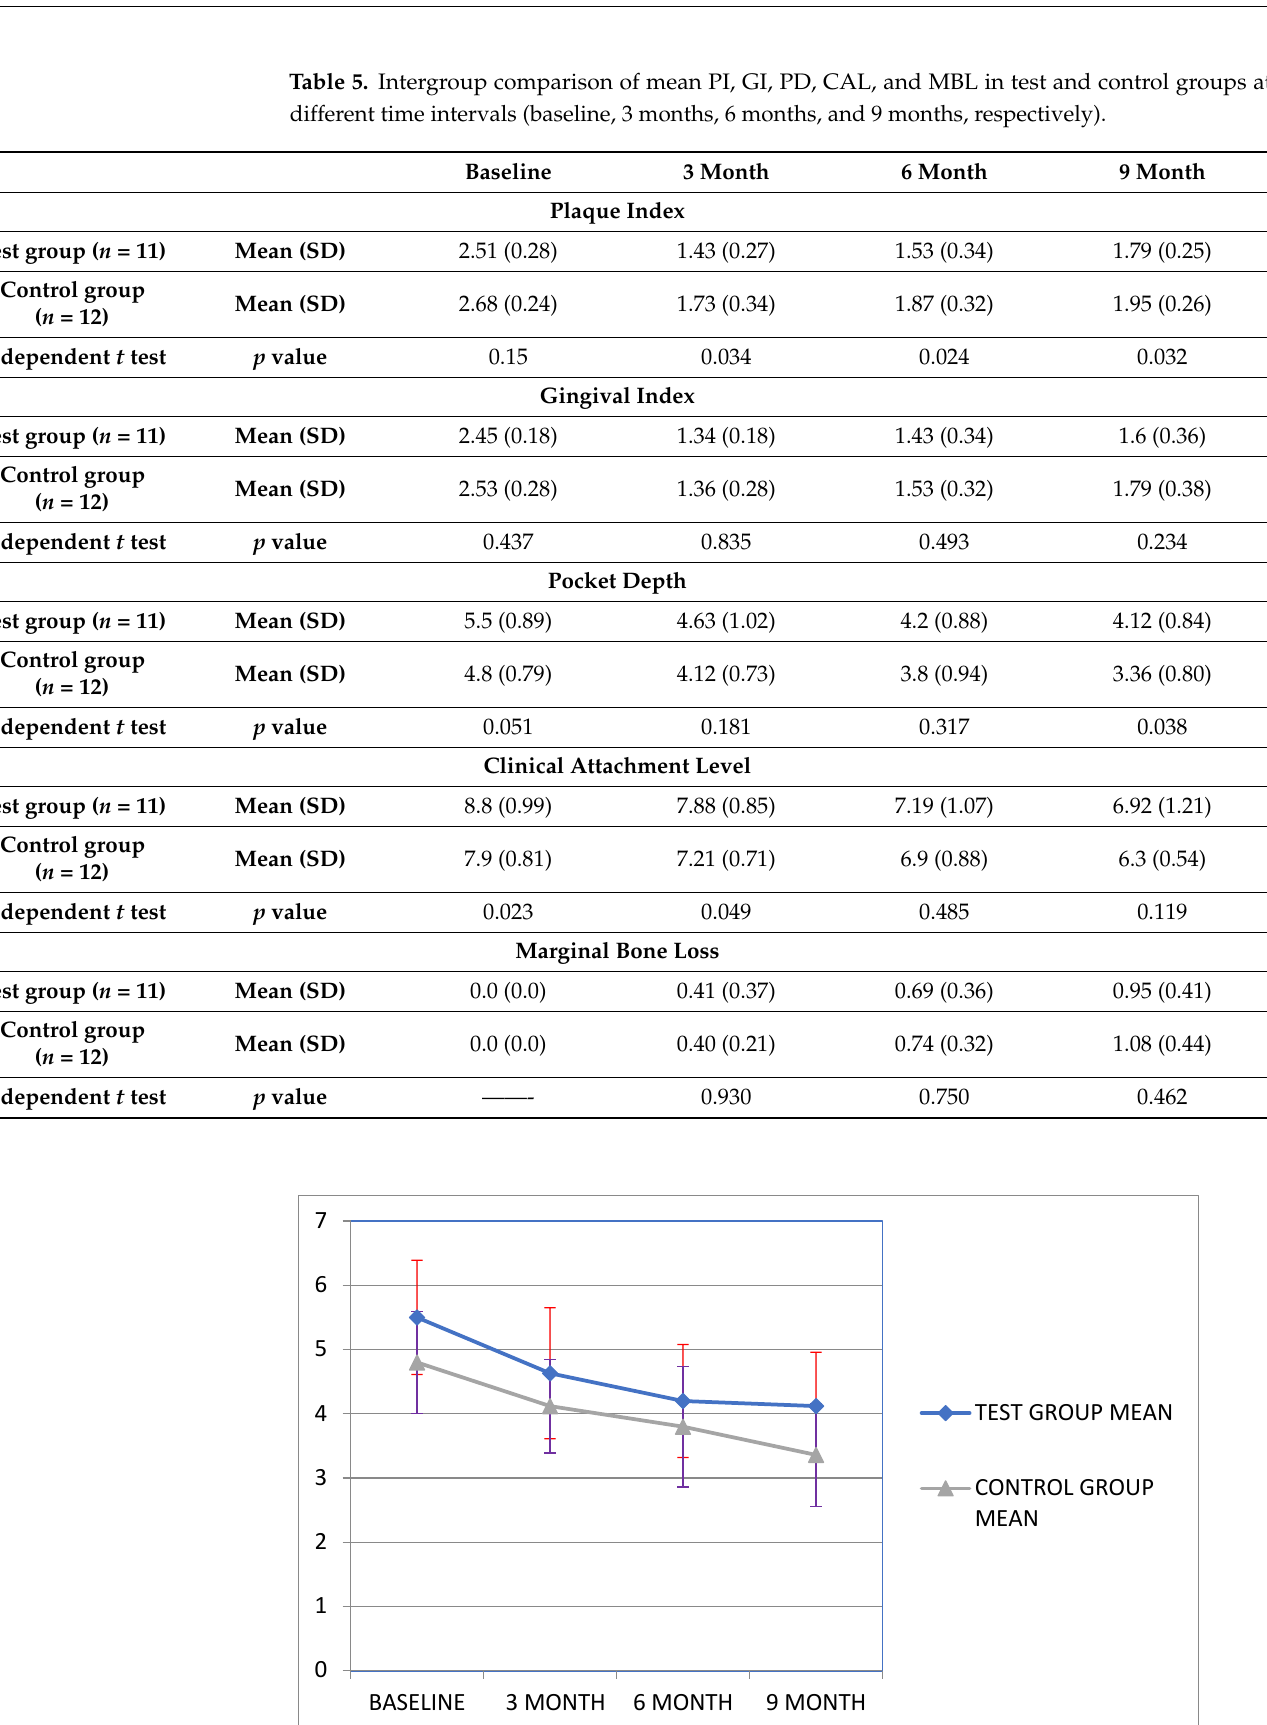
Scheme 2. Intergroup comparison of mean clinical attachment level. TEST GROUP MEAN CONTROL GROUP MEAN